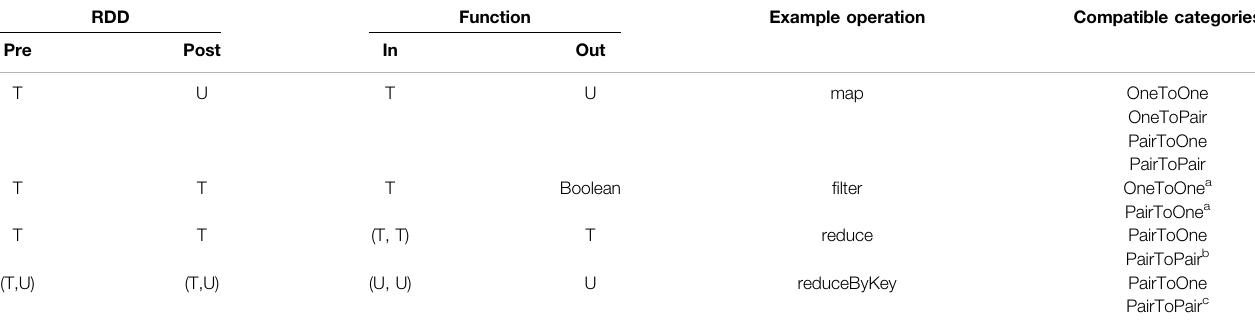
TABLE 2 | Operation shape categories, where T and U are placeholders for some type and (T, U) represents a tuple of type T and U. RDD Function Example